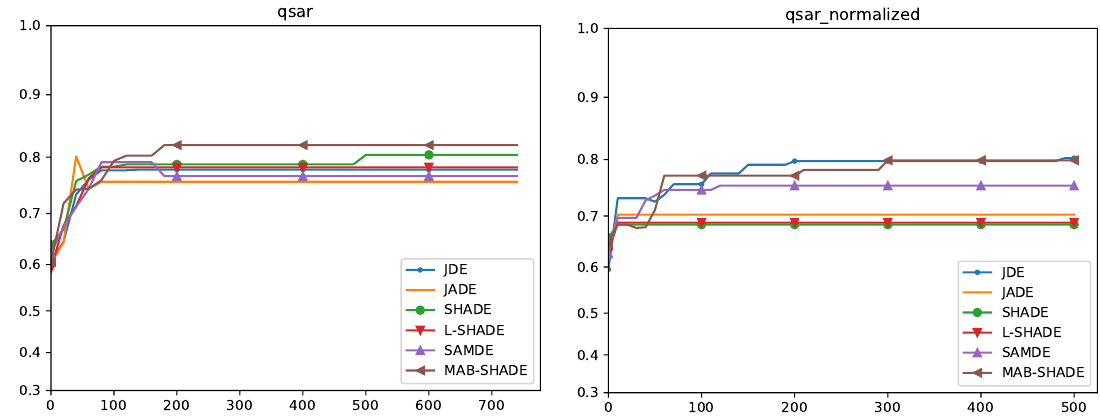
Figure 2. Plots of convergences on QSAR and QSAR normalized